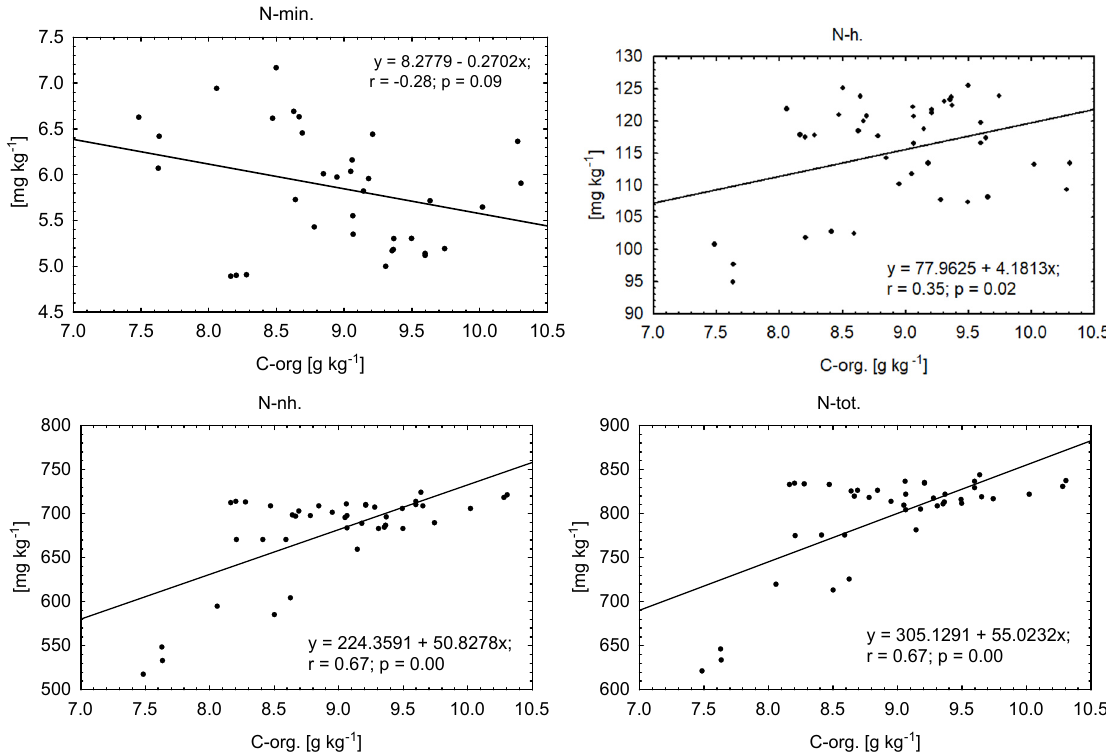
Figure 4. Content of selected N fractions depending on the soil content of C-org. ( n = 42; N-min.—mineral; N-h.— hydrolysable (easily + hardly); N-nh.—non-hydrolysable;